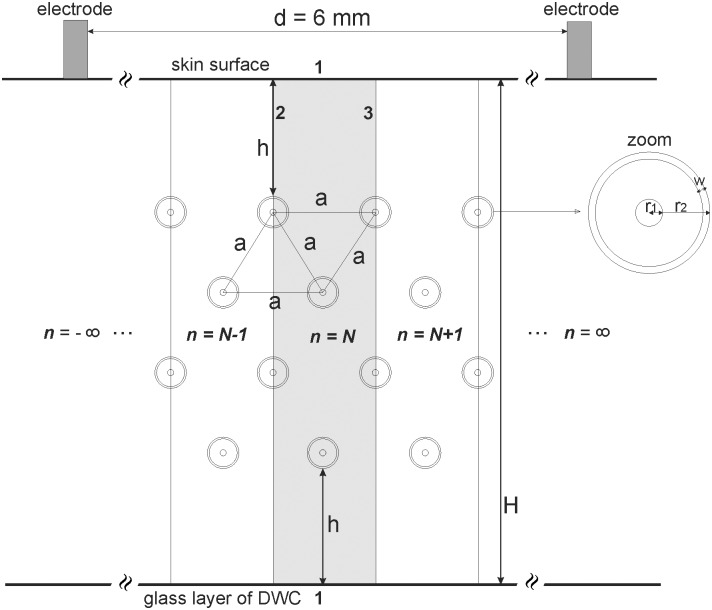
The modeled infinite geometry of skin and capillaries.Infinite geometry is created by infinitely repeating the grayed-out region which we realized in Comsol Multiphysics by applying boundary conditions of symmetry at the inner boundaries 2 and 3. The height of the skin layer was H = 300 μm. The radius of microvessels was r = 3.5 μm. The distance from the skin surface to the capillaries was h = 72 μm. The distance between the centers of neighboring capillaries was a = 60 μm. The thickness of capillary wall was w = 1 μm. The distance between electrodes was d = 6mm.